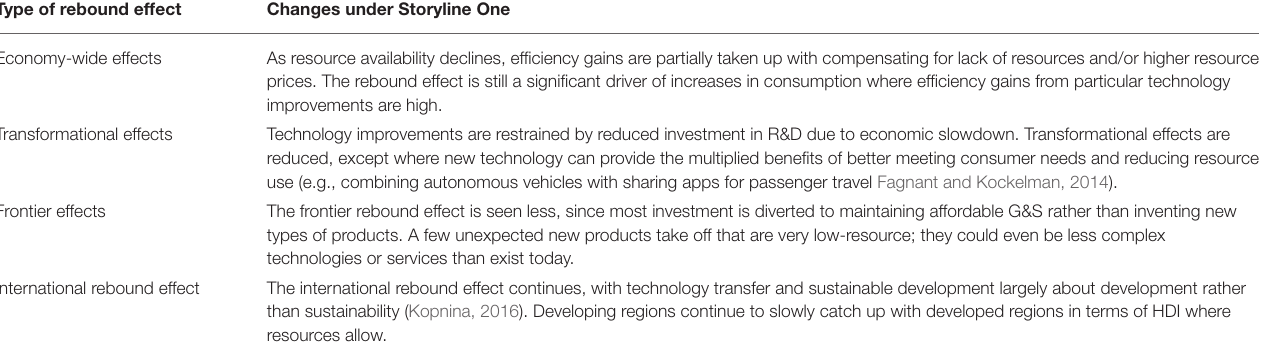
TABLE 4 | Storyline one changes in four types of macro-level rebound